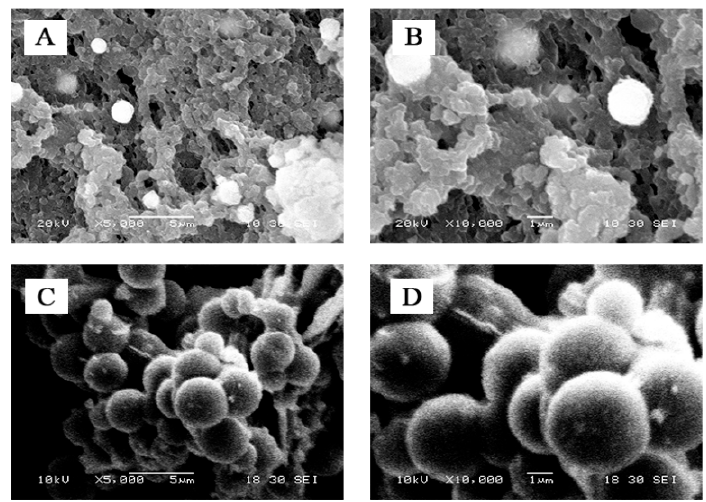
Figure 1. SEM images of the two ferrocenyl microporous polymers networks for PFcMOP ( A , B ) and CFcMOP ( C , D ).